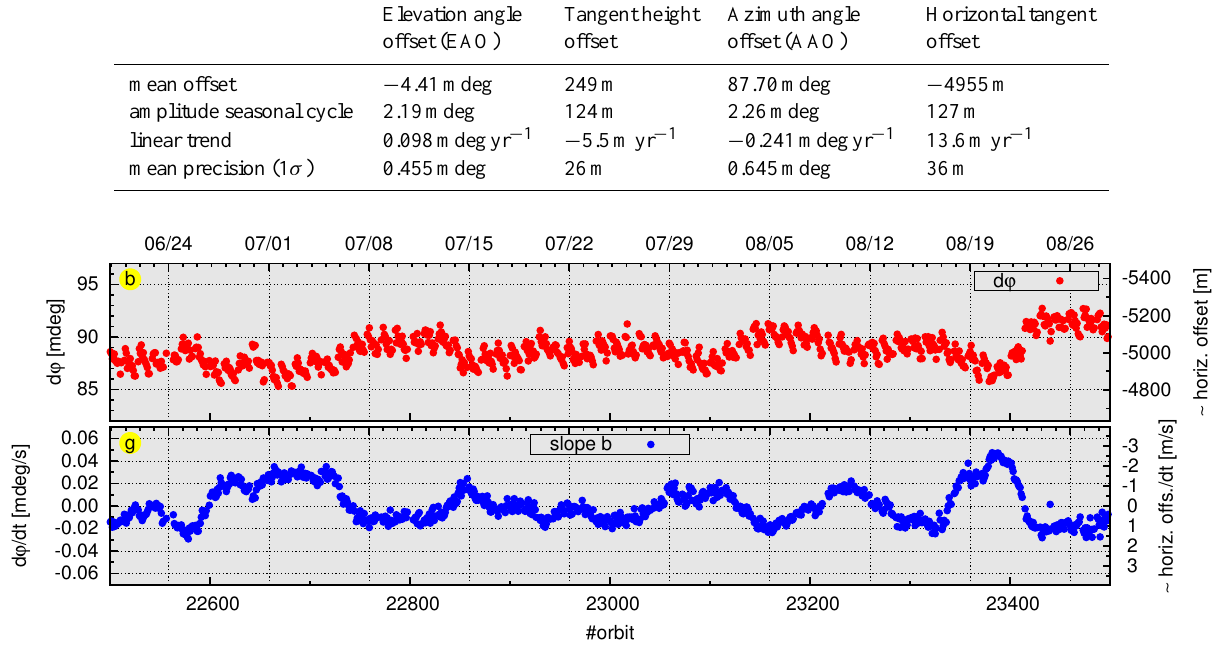
Fig. 14. Zoom of Fig. 13 (b) and (g) with the time range June to August